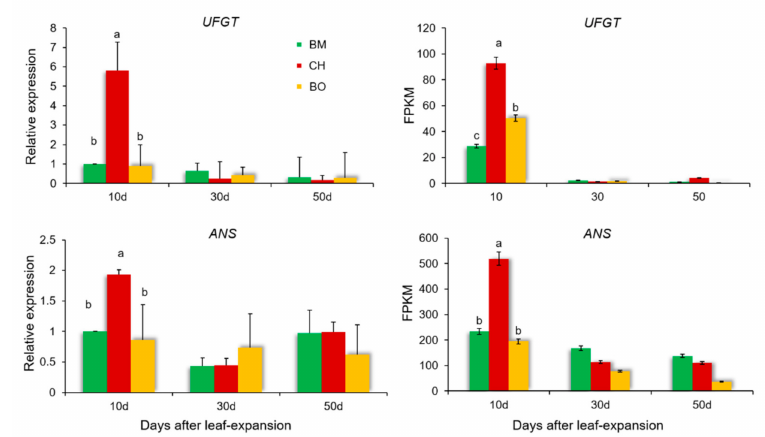
Figure 7. Verification of RNA-seq data using qPCR. The transcription levels of Camellia japonica genes UFGT and ANS in RNA-seq are indicated by fragments per kilobase per million (FPKM). The qPCR data are means ± standard deviation (SD), n = 3. Di ff erent letters above the bars indicate significant di ff erences (for qPCR, p < 0.05, one-way ANOVA; for RNA-seq, FDR < 0.05). Together, the molecular basis of leaf color alteration from red to green and the anthocyanin content reduction in CH involved genes modulating phenylpropanoid biosynthesis pathway and anthocyanins accumulation. ANS and UFGT were two of the core functional